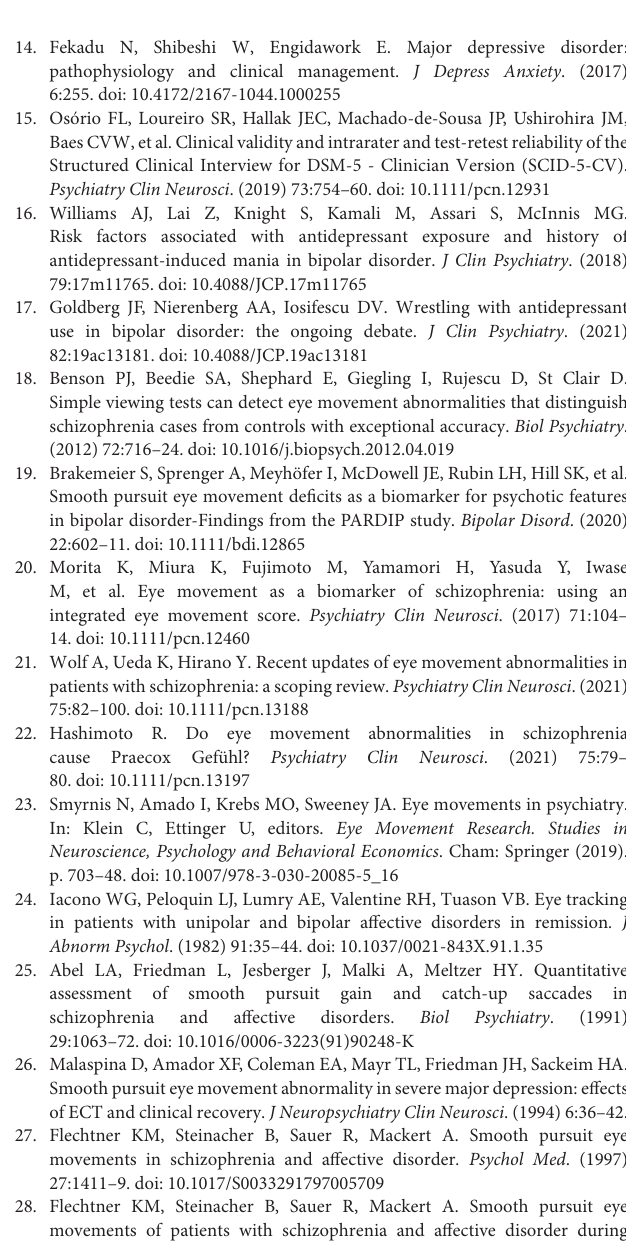
Supplementary Table 1 | Eye movement measurements of HCs and MDD subjects. Supplementary Table 2 | Results of t -tests between age-matched